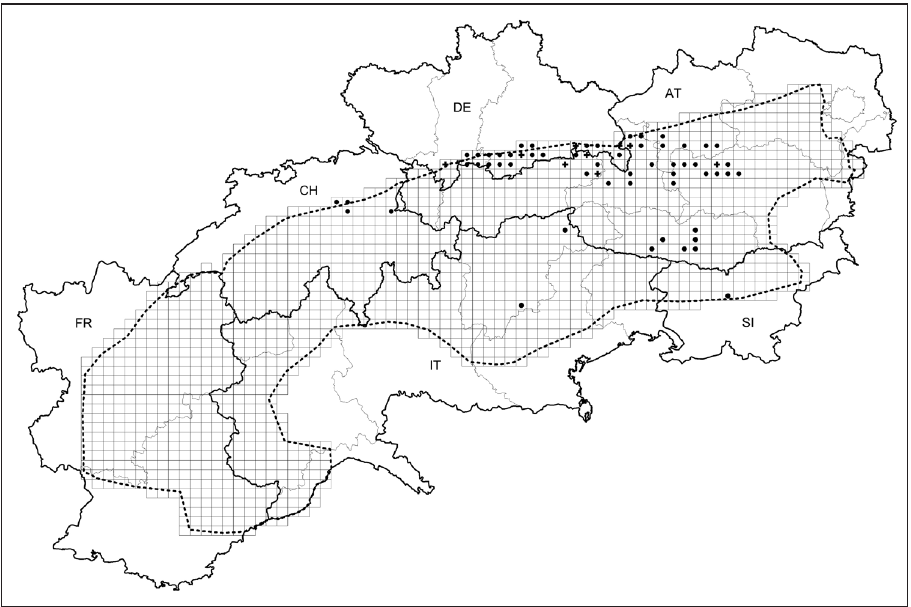
Figure 2. Distribution map of Hammarbya paludosa (L.) Kuntze in the Alps (dotted line) after the MTB- grid (see Ehrendorfer and Hamann 1965). The data are drawn from the following sources: https://www. infoflora.ch/it/ (accessed 24.06.2016) for Switzerland; Bettinger et al. (2013) for Germany; Griebl (2013) for Austria, with integrations by H. Niklfeld and K. Zernig (in litt.); Jogan (2001) for Slovenia. Dots: confirmed after 1950 ca.; crosses: not confirmed after 1950